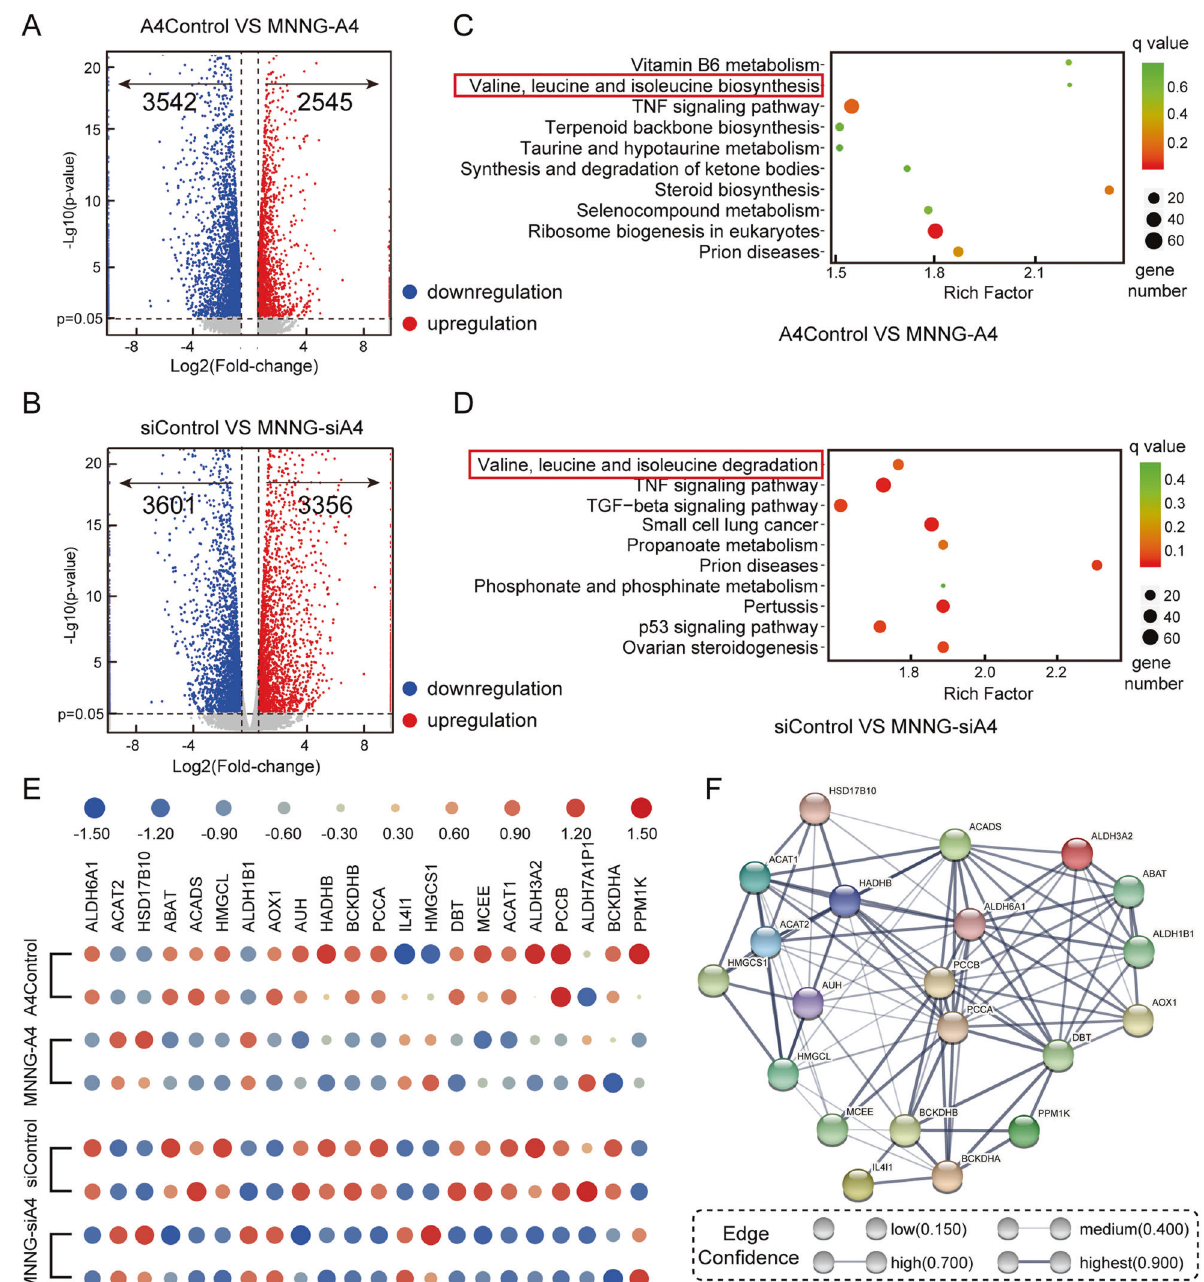
Fig. 3 The signaling mechanism of the effects of ANGPTL4 on OS growth by RNA-seq. A , B Volcano plots of the differentially expressed genes (DEGs) in the MNNG-A4 cells, MNNG-siA4 cells, and control cells. Fold change values on the X -axis were log2-transformed while p values on the Y -axis were − log10 transformed. The screening criteria for DEGs were p value <0.05 and expression level higher than 1.5-fold or lower than 0.67-fold. C , D KEGG pathway enrichment analysis for DEGs in the MNNG-A4 cells, MNNG-siA4 cells, and control cells. E Heatmap of the BCAA-associated DEGs between the ANGPTL4-regulated cells and the control cells. F The protein-protein interaction network provided interactive information for the branched-chain amino acid (BCAA)-associated DEGs. upregulated while the expression of AHU , AOX-1 , ALDH6A1 , (https://string-db.org/) database to construct the protein-protein BCKDHA , BCKDHB, IL4I-1, SDSL , and ACADS was downregulated in interaction network. As shown in Fig. 3F, these genes are closely the MNNG-A4 cells. These genes showed the opposite pattern in clustered together and form a complex network, which shows the the MNNG-siA4 cells. Furthermore, the western blot results precise inter-regulatory relationship of these genes that are highly con fi rmed that the protein expression levels of some important involved in BCAA metabolism. genes (AOX-1, BCKDHA, IL4I-1, and HMGCL) were consistent with To verify the results of RNA-seq, we then detected the their mRNA levels (Fig. 4C). To further con fi rm our hypothesis, we expressions of these genes in the ANGPTL4 -regulated MNNG cells. measured the BCAA concentrations in both the MNNG-A4 and The RT-qPCR results were consistent with the RNA-seq results. As MNNG-siA4 cells and their control cells. As shown in Fig. 4D, the shown in Fig. 4A, B, the expression of HMGCL and ABAT was Cell Death Discovery (2022)